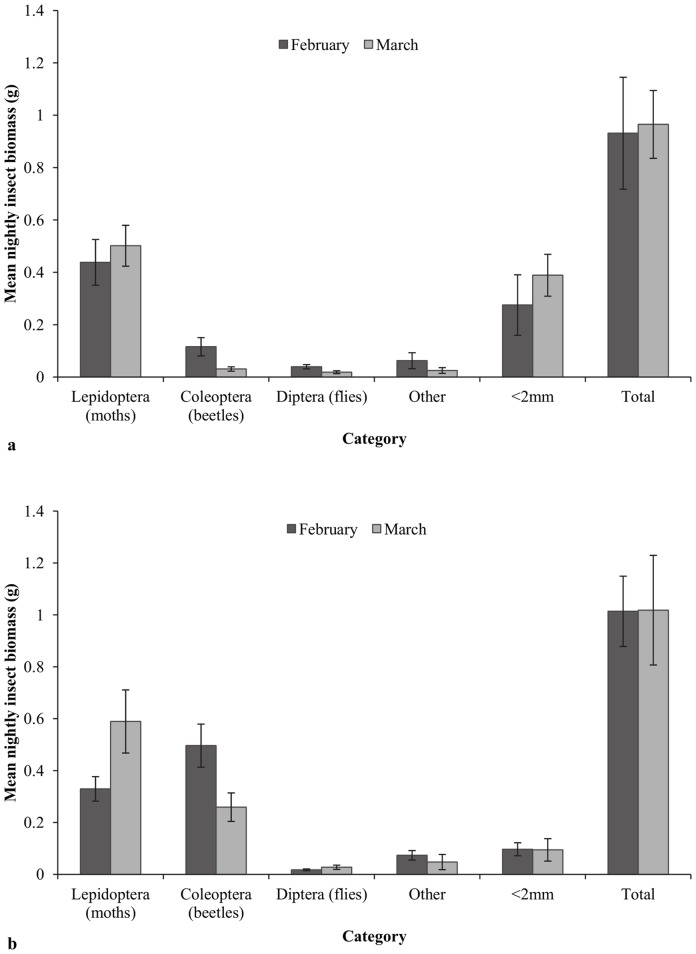
Nightly insect biomass.Mean nightly insect biomass and insect biomass separated by taxa or size during February 2010 and March 2010 in: a) saltmarsh and b) coastal swamp forest. Error bars represent ±1 standard error from the mean.